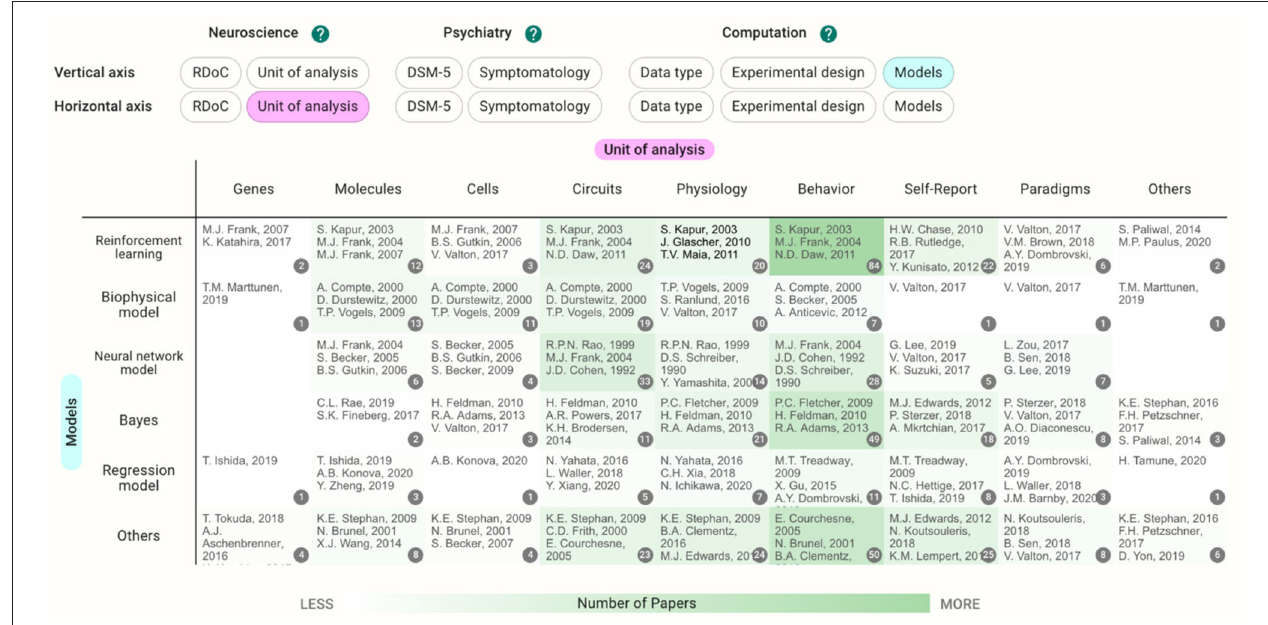
FIGURE 1 | Example view of the heatmap section. Darker green shading indicates areas with many papers, and lighter shading indicates areas with few papers. “Unit of analysis” was chosen as the horizontal axis and “Model” was chosen as the vertical axis.